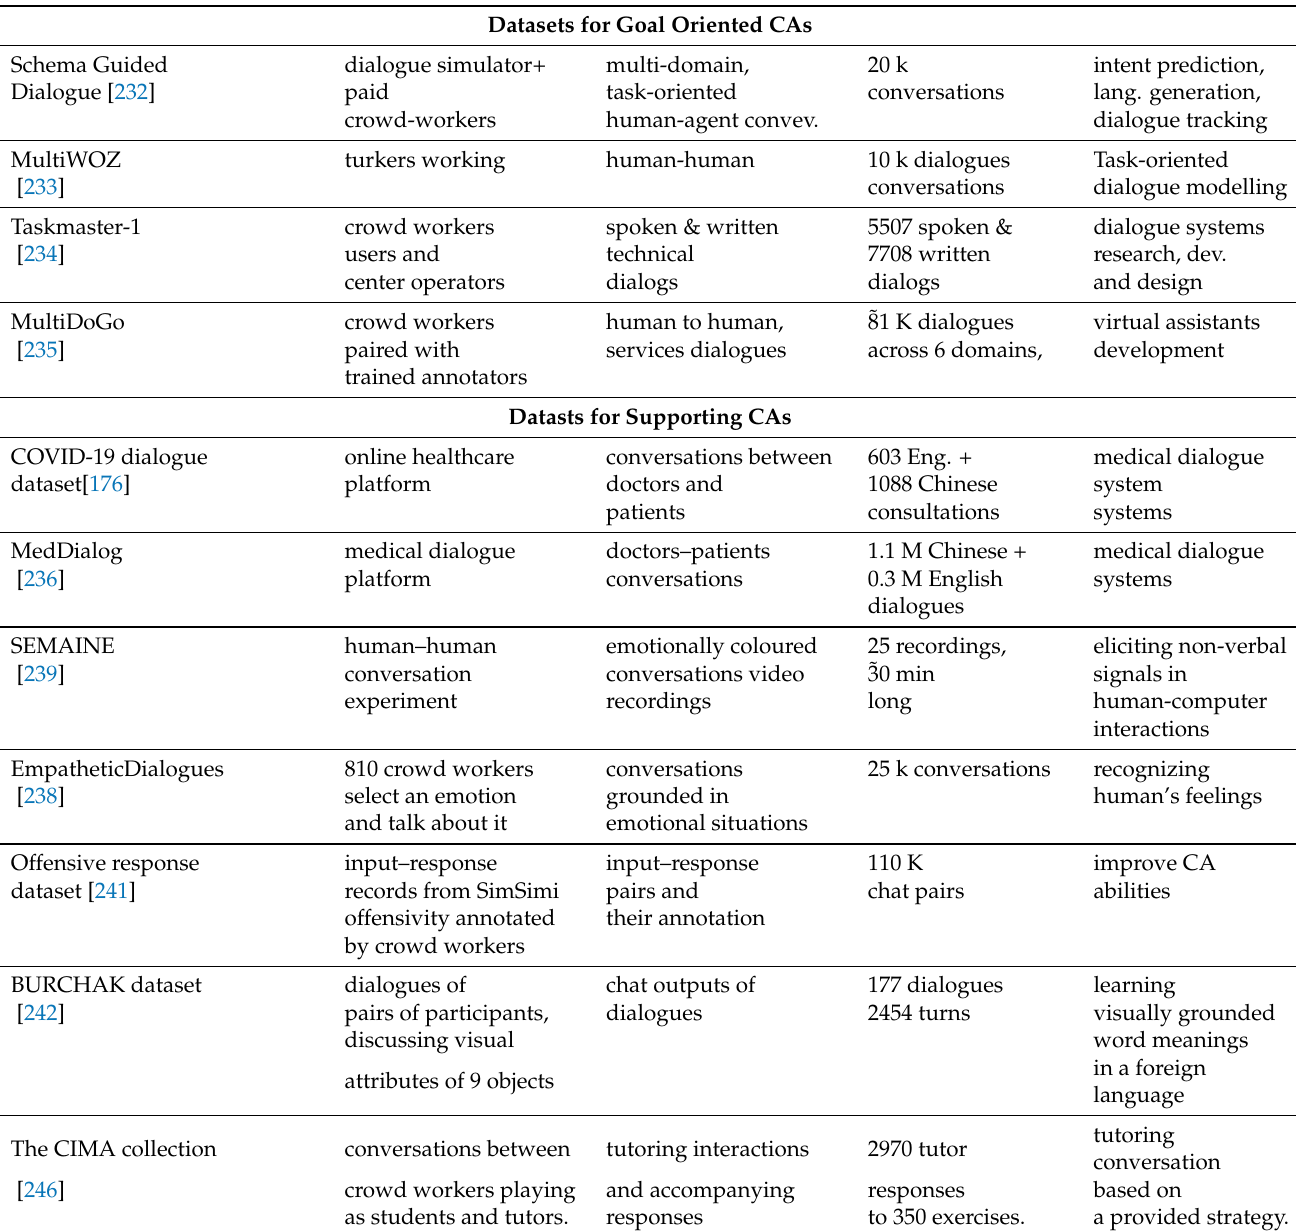
Table 4. Main available datasets for conversational agents—part